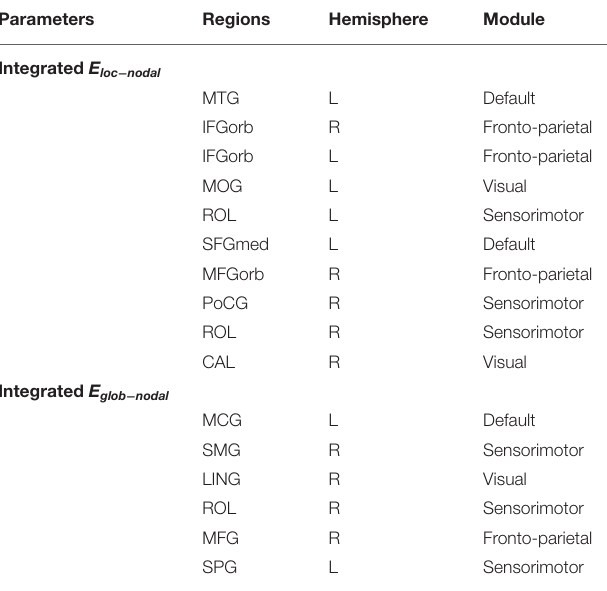
TABLE 2 | Brain locations involved in the multiple linear regression analysis (MLRA) for integrated nodal parameters in the critical time point- (CTP-) network. Parameters Regions Hemisphere